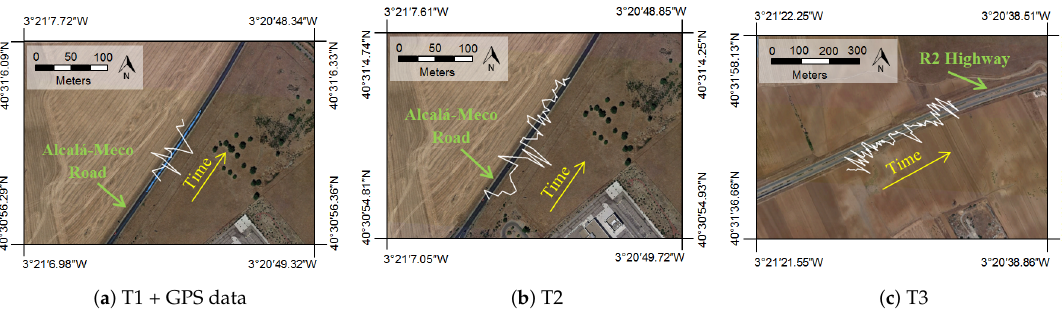
Figure 24. 2D estimated trajectories and GPS data in the radar